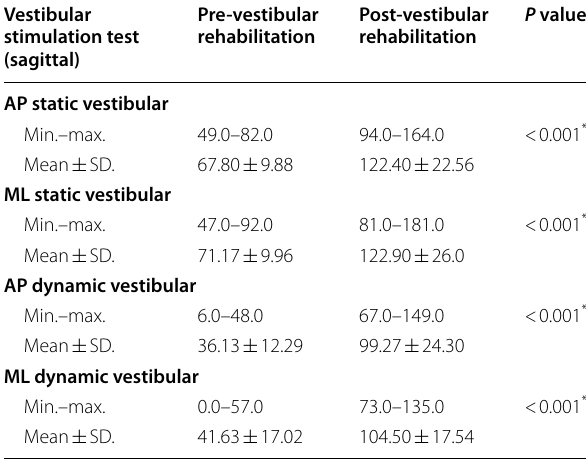
SD standard deviation